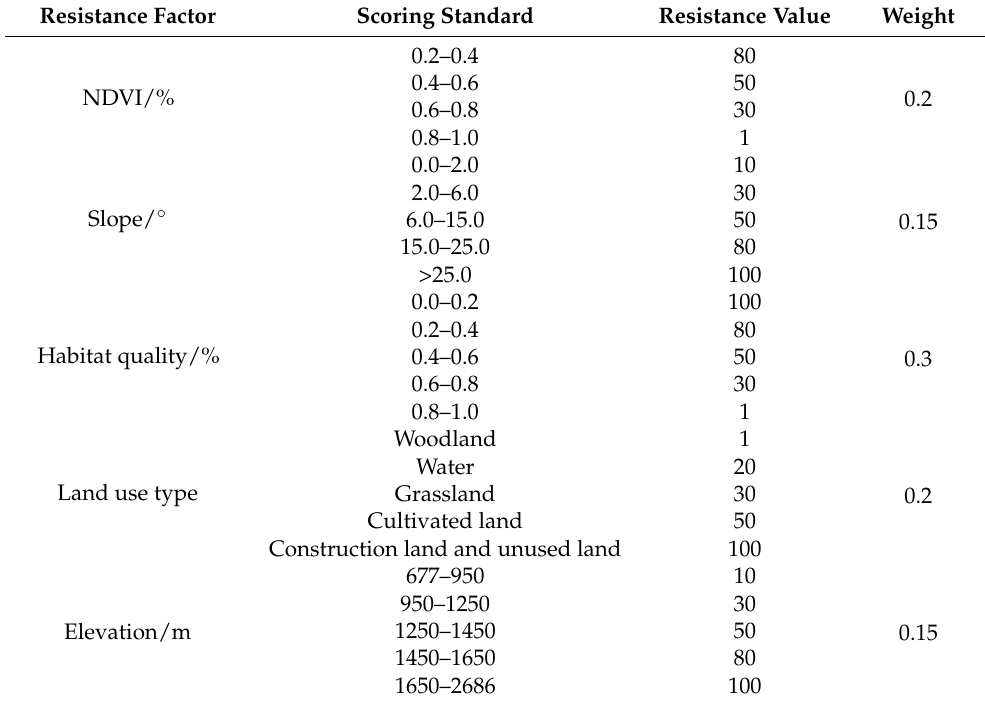
Table 5. Classification and weight of each resistance